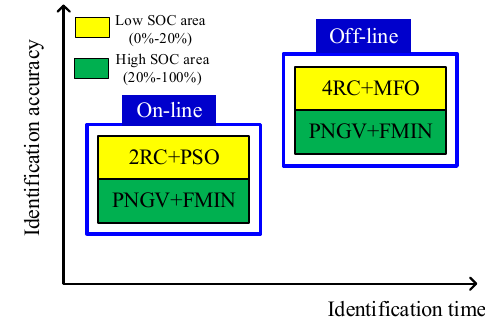
Figure 7. Schematic diagram of multi-model and multi-algorithm combinations.